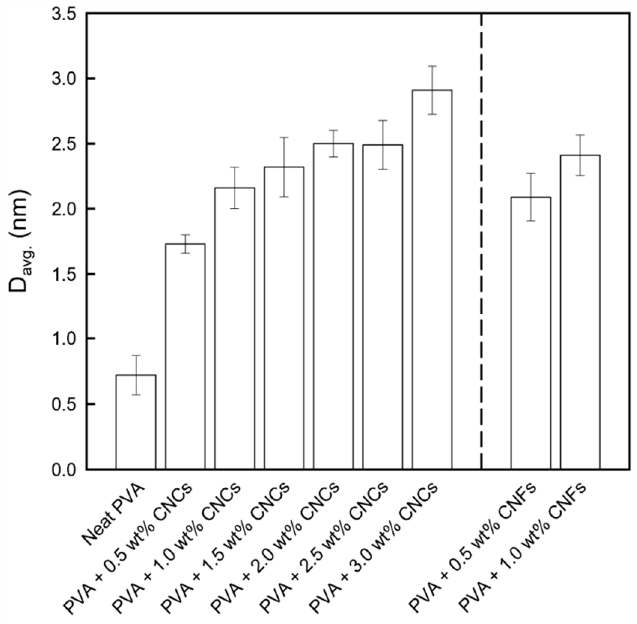
Figure 5. Grain sizes of the PVA + CNC/CNF nanocomposite films.